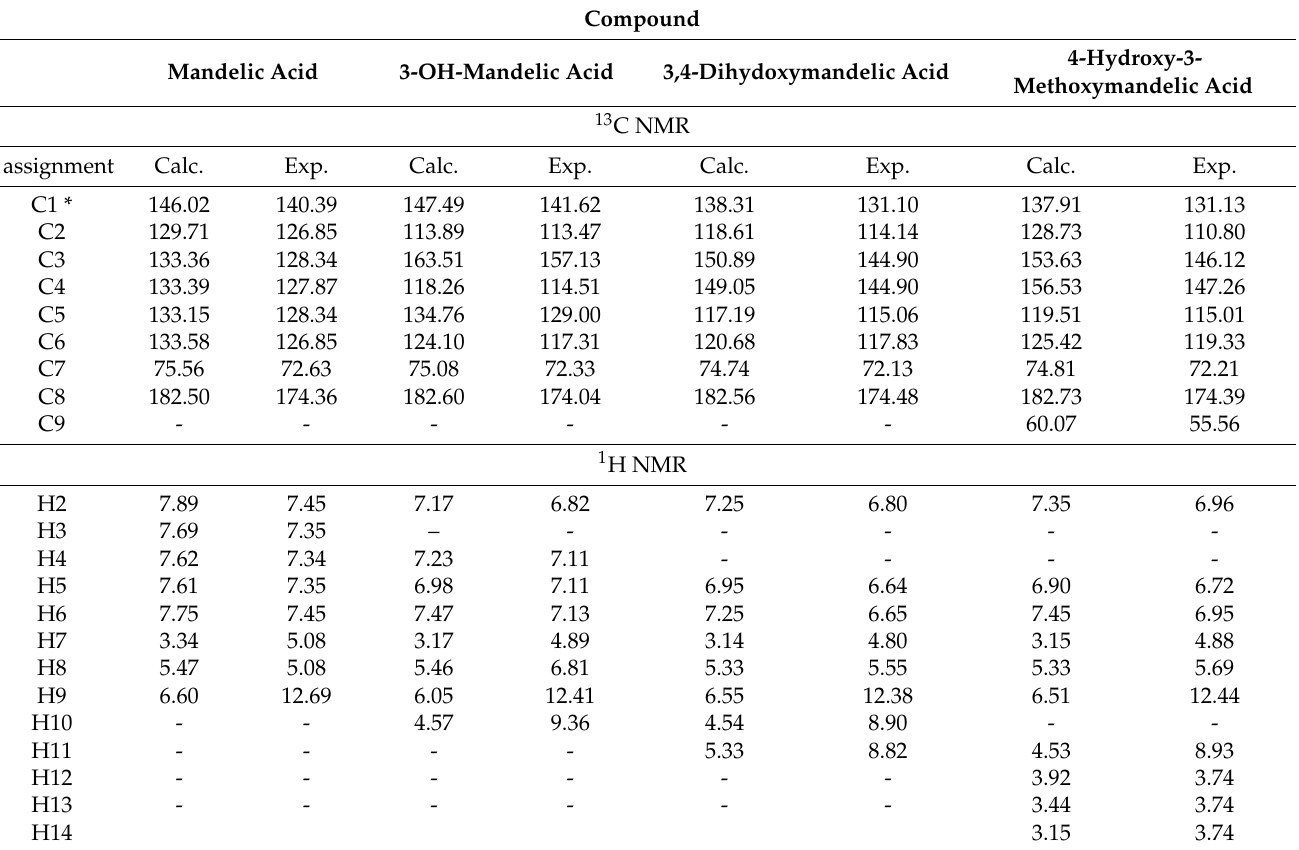
Table 7. Experimental and theoretical chemical shifts ƍ [ppm] for mandelic acid and its